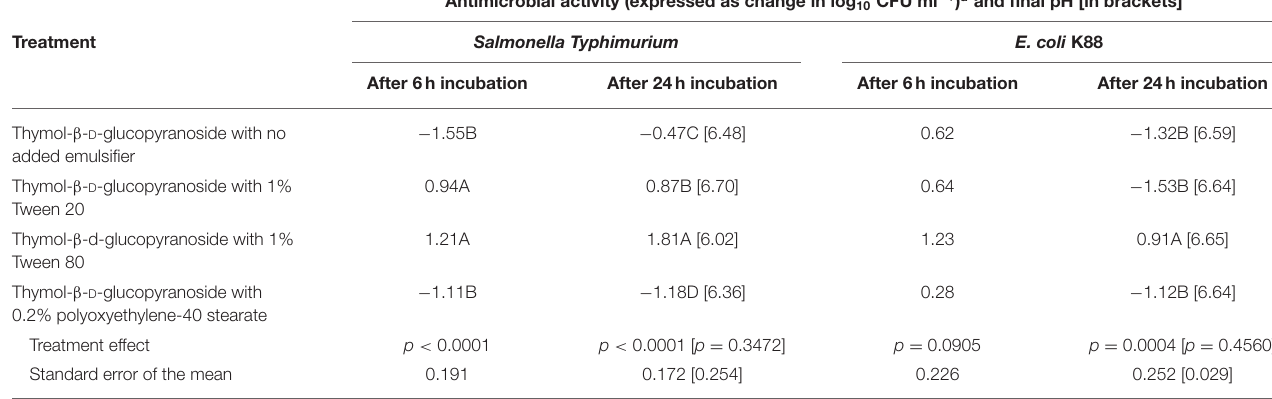
TABLE 3 | Effect of select emulsifiers on vegetable oil-caused antagonism of anti- Salmonella Typhimurium and anti- E. coli K88 activities of thymol- β - D -thymol (6mM) and on final pH during mixed culture with porcine fecal microbes supplemented with 6mM thymol- β - D -glucopyranoside and 3% vegetable